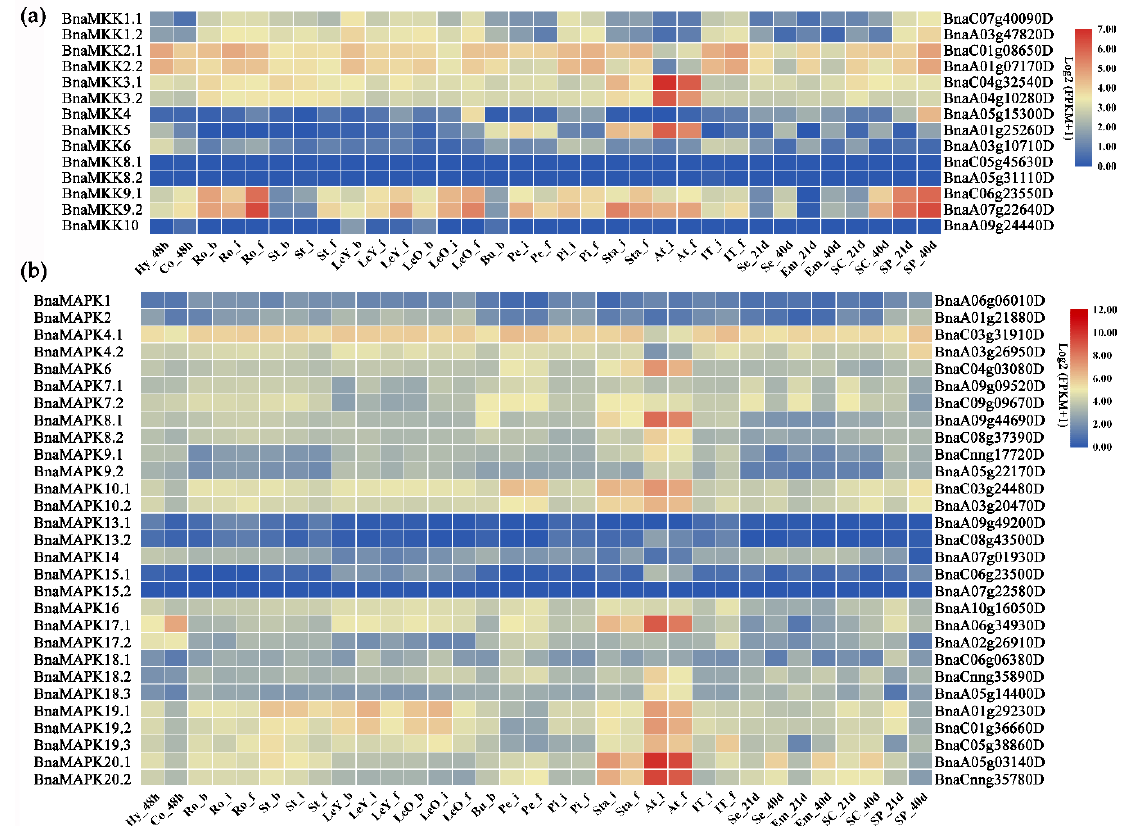
Figure 6. Spatial and temporal expression pattern of BnaMKK and BnaMAPK genes. ( a ) Heatmap of the expression profiles of BnaMKK genes in different tissues and developmental stages. ( b ) Heatmap of the expression profiles of BnaMAPK genes in different tissues and developmental stages. Hy_48h, hypocotyl 48 h after germination; Co_48h, cotyledon 48 h after germination; Ro_b, root at the bolting stage; Ro_i, root at the initial flowering stage; Ro_f, root at the flowering stage; St_b, stem at the bolting stage; St_i, stem at the initial flowering stage; St_f, stem at the flowering stage; LeY_b, young leaf at the bolting stage; LeY_i, young leaf at the initial flowering stage; LeY_f, young leaf at the flowering stage; LeO_b, mature leaf at the bolting stage; LeO_i, mature leaf at the initial flowering stage; LeO_f, mature leaf at the flowering stage; Bu_b, bud at the bolting stage; Pe_i, petal at the initial flowering stage; Pe_f, petal at the flowering stage; Pi_i, pistil at the initial flowering stage; Pi_f, pistil at the flowering stage; Sta_i, stamen at the initial flowering stage; Sta_f, stamen at the flowering stage; At_i, anther at the initial flowering stage; At_f, anther at the flowering stage; IT_i, tip of main inflorescence at the initial flowering stage; IT_f, tip of main inflorescence at the flowering stage; Se_21d, seed 21 days after flowering; Se_40d, seed 40 days after flowering; Em_21d, embryo 21 days after flowering; Em_40d, embryo 40 days after flowering; SC_21d, seed coat 21 days after flowering; SC_40d, seed coat 40 days after flowering; SP_21d, silique pericarp 21 days after flowering; SP_40d, silique pericarp 40 days after